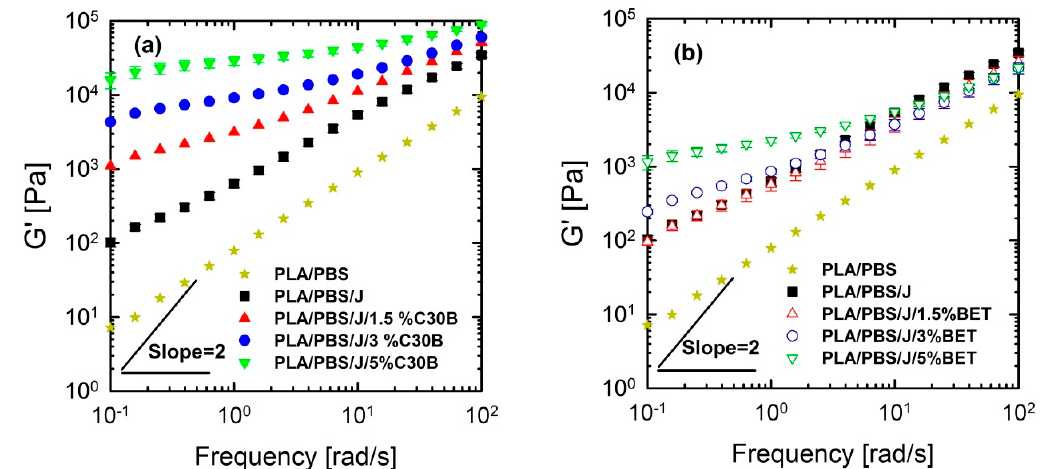
Figure 10. Storage (elastic) moduli of the PLA/PBS and PLA/PBS/J blends at various concentration of ( a ) C30B and ( b ) BET, at 190 ° C. Strain amplitudes were small (0.5 − 1%) to ensure linear response. BET is Betsopa™, C30B is Cloisite ® 30B, and J is Joncryl.